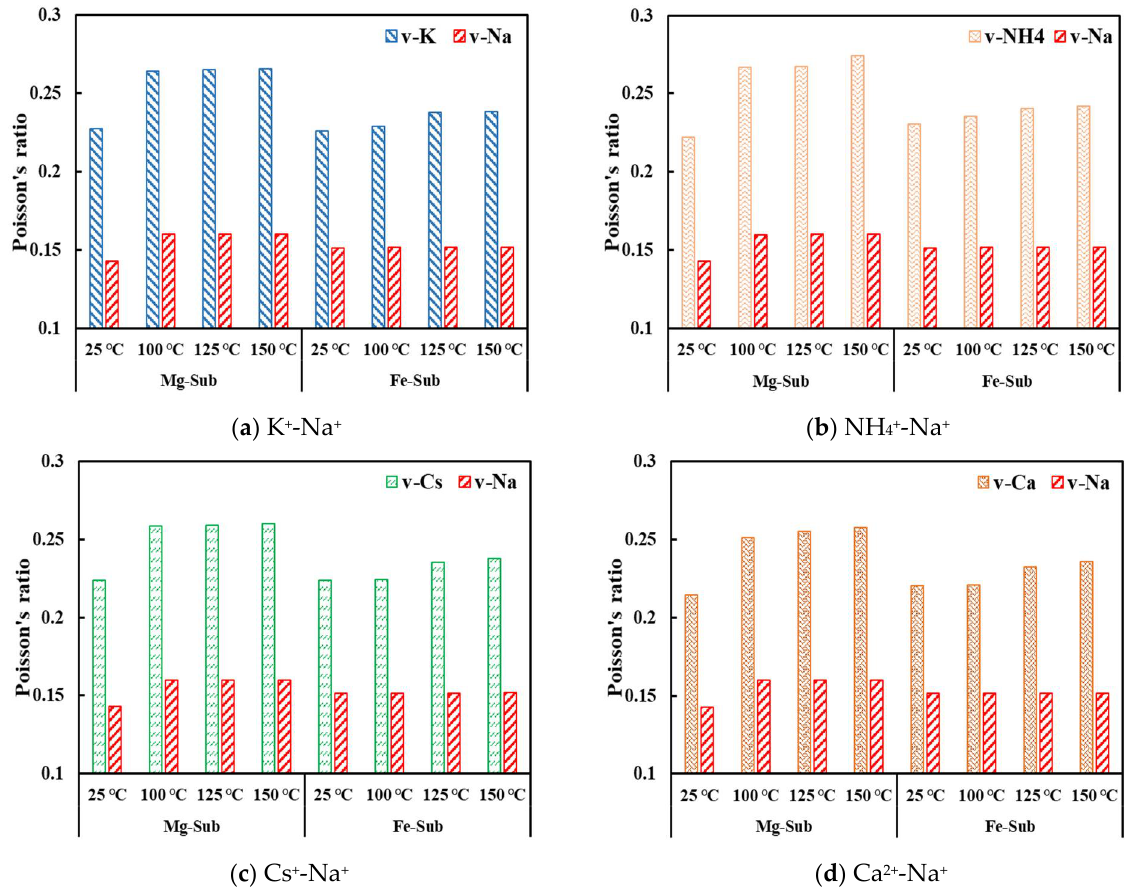
Figure 10. Poisson’s ratio of MMT crystals under different temperatures and inhibiting cations.